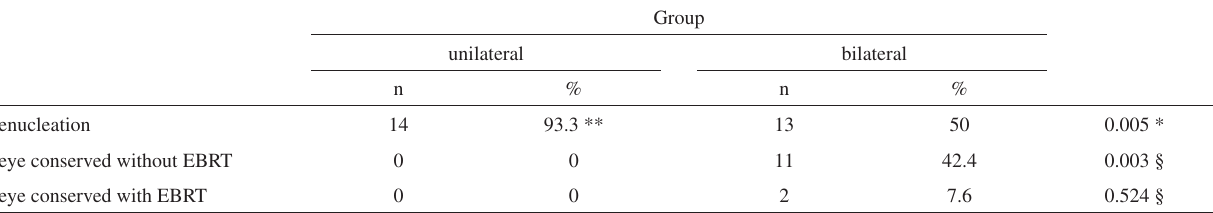
Table 4 - Enucleation and conservation rate in unilateral and bilateral retinoblastoma. All eyes in the unilateral group were enucleated. Half of the eyes were preserved in the bilateral group, including 42% without the need of